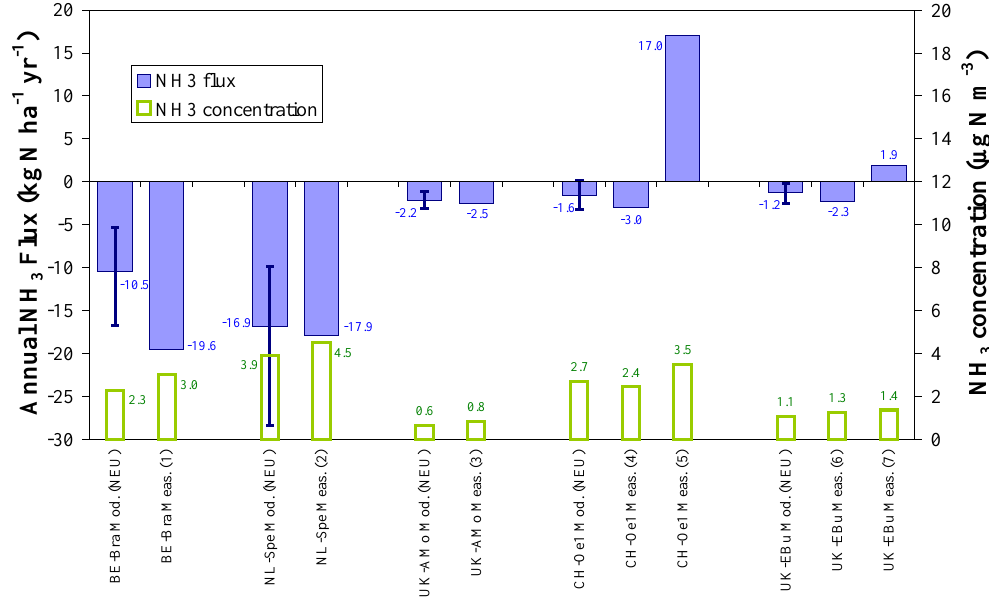
Fig. 6. Comparison of modelled annual NH 3 exchange from NEU network DELTA data with measured estimates from historical long-term micrometeorological flux datasets. For five monitoring sites, the ensemble average of CBED, CDRY, EMEP-03 and IDEM is shown with error bars showing the range (min, max) of model estimates. (1): Neirynck et al., 2007; (2): Erisman et al. (1996); (3): Flechard (1998); (4) and (5): data from Flechard et al. (2010), showing (4) the annual NH 3 flux for background conditions (outside fertilisation events) and (5) the net emission flux from the whole dataset; (6) and (7): data from Milford (2004), with (6) the annual dry deposition, calculated from the net overall flux (7) minus the gross annual emission of 4.2kgNha − 1 yr − 1 due to grassland management activities (fertilisation, cuts). The secondary axis shows the mean concentrations during the NEU reference period (2007–2008) as well as during the flux monitoring